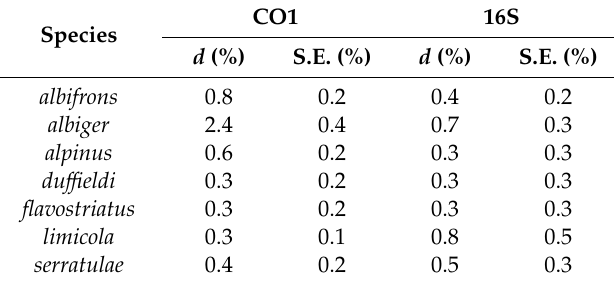
Table 3. Within-group (intraspecific) mean pairwise distances (d) with corresponding standard errors (generated by MEGA v6.0; [56] for CO1and 16S, for Anoscopus species. Anoscopus histrionicus was not included as there was only one individual available. d = divergence, S.E. = standard error. CO1 16S Species d (%) S.E. (%) d (%) S.E. (%)